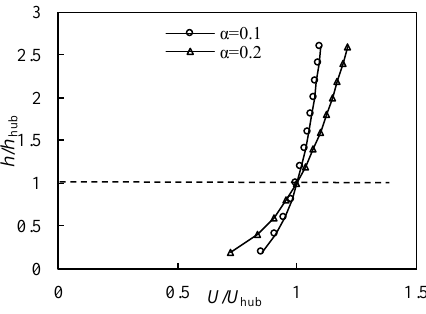
Figure 11. Atmospheric boundary layer profiles.